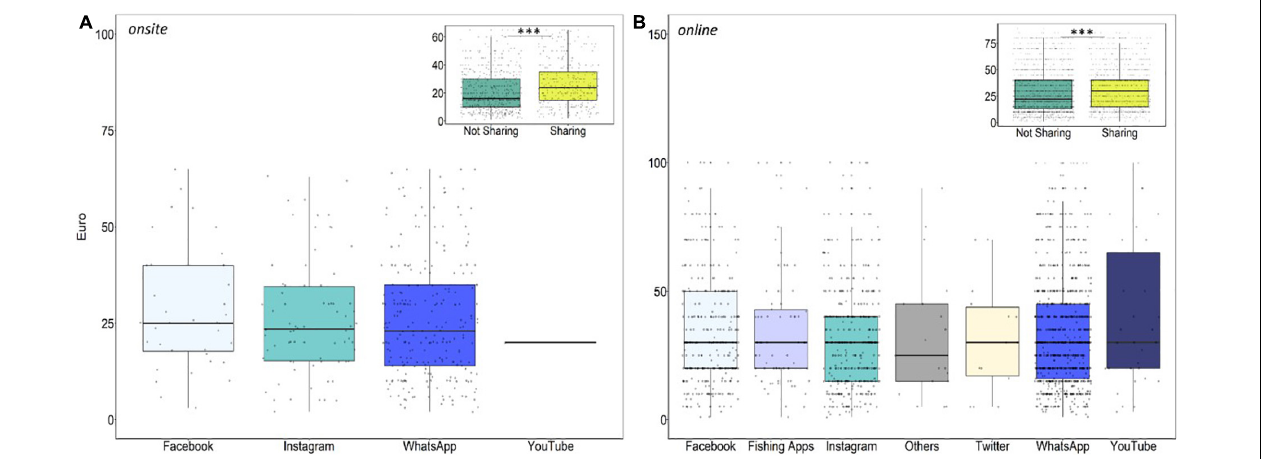
FIGURE 6 | Boxplots comparing total expenditure during the past fishing trip for sharers and non-sharers (inlets), and according to the different platform used to share, from the onsite (A) and the online (B) surveys. In the onsite survey (A) , daily expenditure of non-sharers averaged 21 euro, while it was 26 euro for sharers (YouTube: N = 1, 20 euro; WhatsApp: N = 241, 26 euro; Instagram: N = 74, 26 euro; and Facebook: N = 36, 28 euro). In the online questionnaire (B) , the expenditure of non-sharers was, on average, 28 euro, while it was 31 euro for sharers (Instagram: N = 354 and Twitter: N = 14, mean = 32 euro; WhatsApp: N = 797 and other platforms: N = 19, mean = 33 euro; Fishing Apps: N = 70, mean = 35 euro; and Facebook: N = 290, mean = 36 euro and YouTube: N = 30, mean = 40 euro). Boxplots represent the median (bold centreline), the 25th (top of the box) and 75th percentile (bottom of the box). Significant differences are reported as follow: ∗∗∗ p < 0.001.